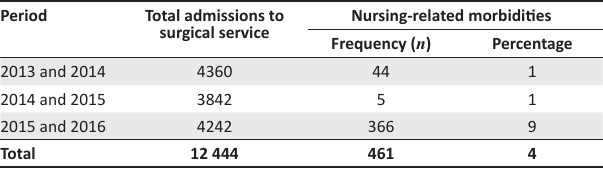
TABLE 1: Nursing-related morbidities per year. Period